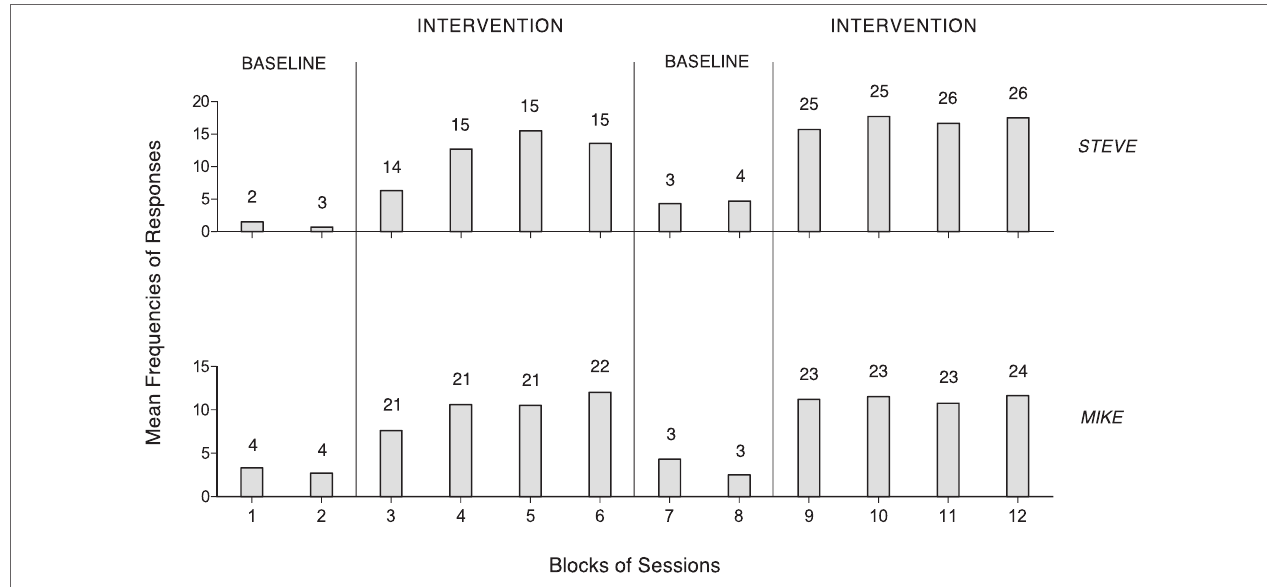
FigUre 1 | The two panels summarize the data for Steve and Mike. The bars represent mean frequencies of response occurrences per session, over blocks of sessions. The number of sessions included in each block is indicated by the numeral above